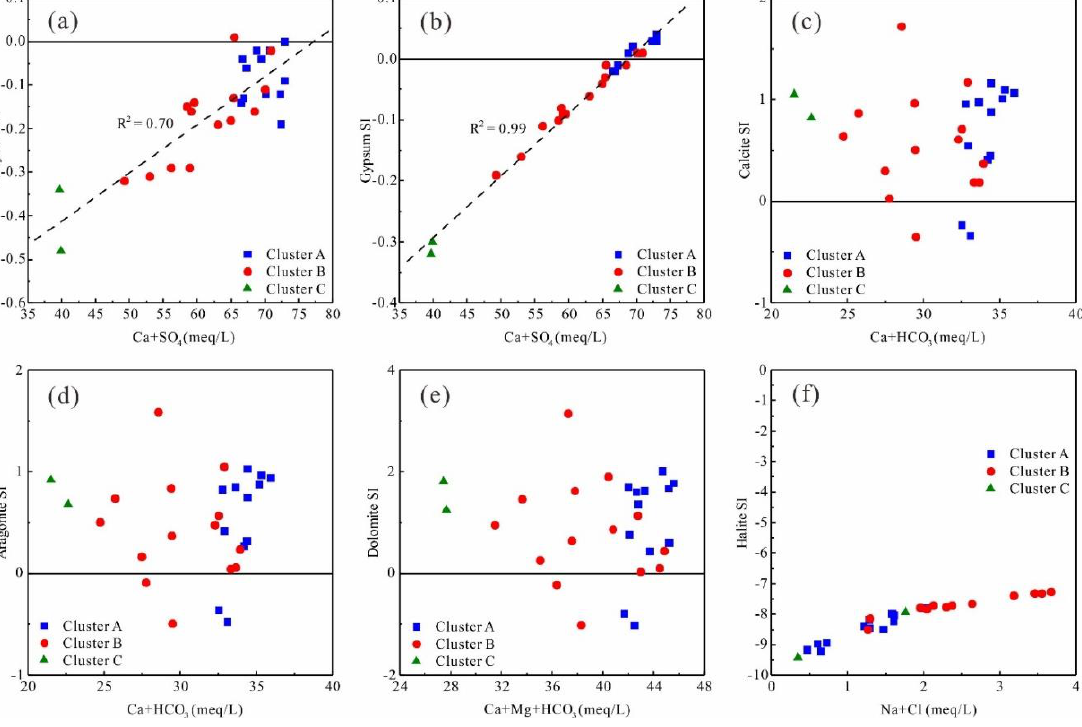
Figure 11. The relationship of ( a ) (Ca 2 + + SO 42 − ) vs. anhydrite SI; ( b ) (Ca 2 + + SO 42 − ) vs. gypsum SI, ( c ) (Ca 2 + + HCO 3 − ) vs. calcite SI; ( d ) (Ca 2 + + HCO 3 − ) vs. aragonite SI; ( e ) (Ca 2 + + Mg 2 + + HCO 3 − ) vs. dolomite SI; ( f ) (Na + + Cl − ) vs. halite SI.